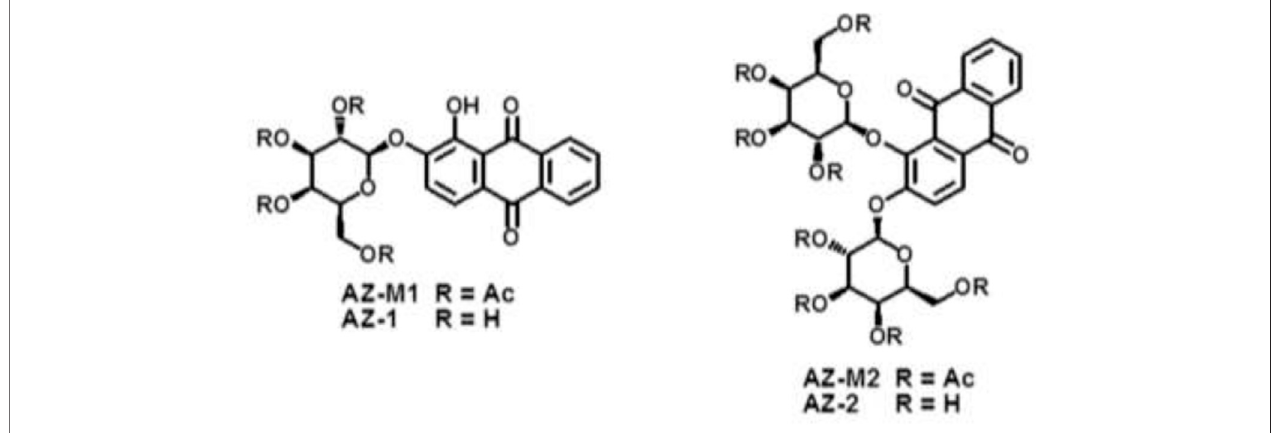
FIGURE 3 | The structures of alizarin mono β - D -galactopyranosides AZ-M1 / AZ-1 , and alizarin di- β - D -galactopyranosides AZ-M2 / AZ-2 .